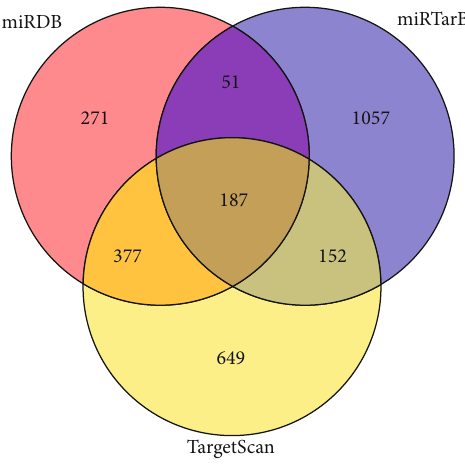
Figure 6: Target genes of miRNAs identi fi ed in the TargetScan, miRDB, and miRTarBase public